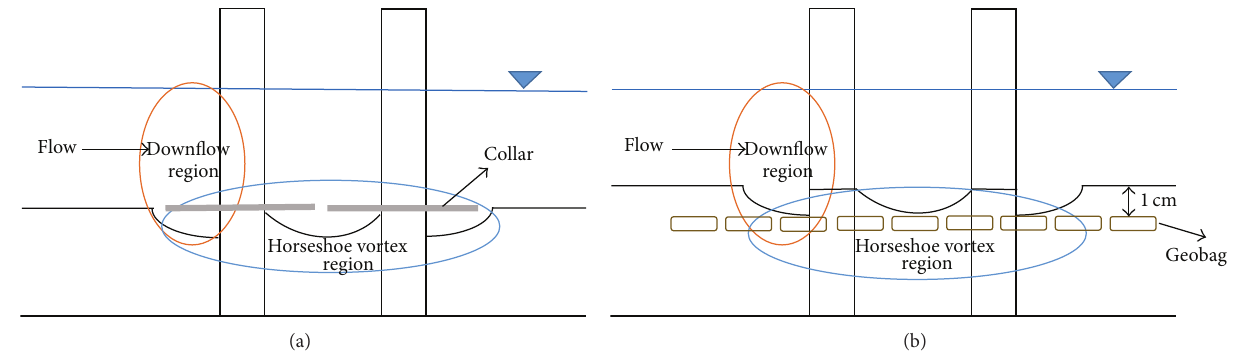
Figure 1: Scour around a pile protected by (a) collar and (b) geobag below